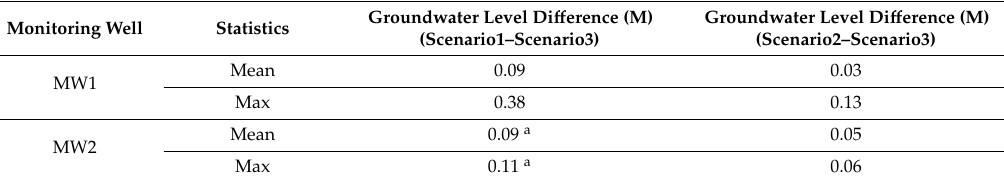
Figure 8. Groundwater levels predicted using LSTM and groundwater withdrawal scenarios for MW1 and MW2. Table 5. Differences between the simulated groundwater levels in groundwater withdrawal scenarios for the entire data period.